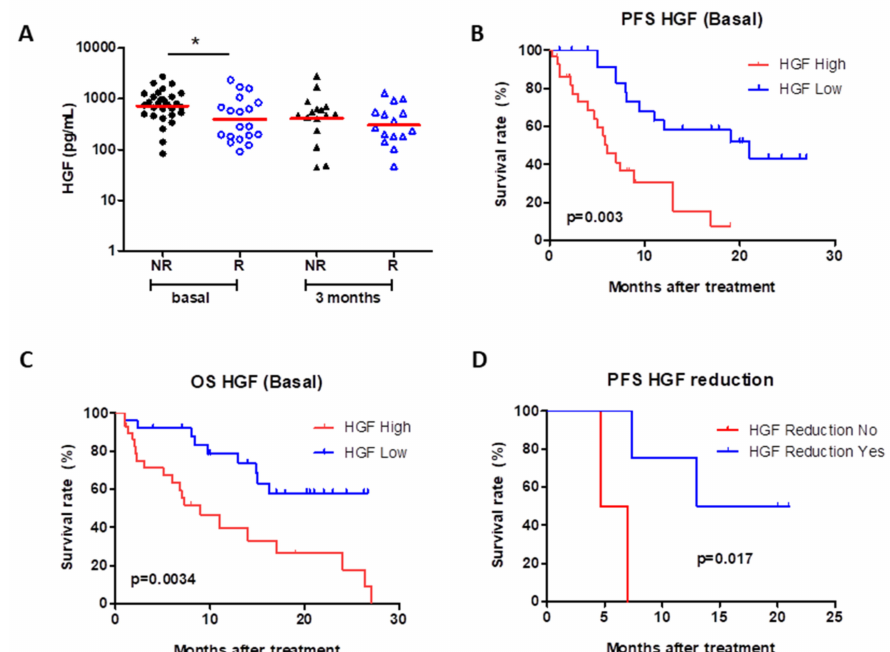
Figure 3. Blood levels of HGF and relationship with response and outcome. At baseline, levels of HGF are higher ( p < 0.05) in patients without response (NR, n = 30) when compared to responders (R, n = 19). No changes were observed 3 months after treatment (NR, n = 16; R, n = 15) ( A ). HGF levels above 649.1 pg/mL are significantly associated with lower PFS ( B ) ( p = 0.003) and OS ( C ) ( p = 0.0034). A reduction in HGF levels after treatment is also significantly associated with lower